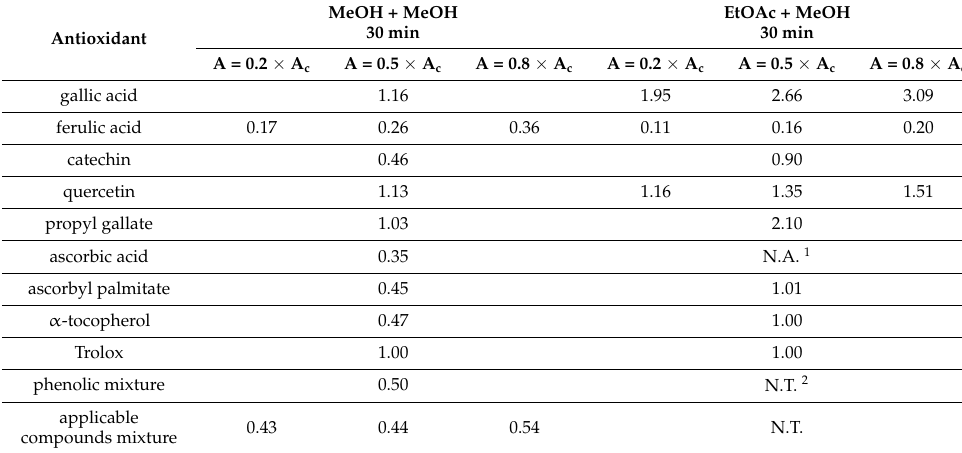
Table 13. TEAC values determined against DPPH radicals applied in methanol or ethyl acetate (radical solution in methanol) after standard reaction